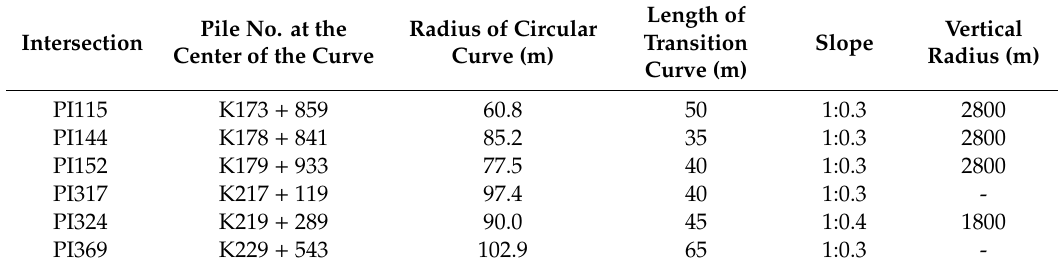
Table 1. The calculation parameters of S.S.D. calculation.